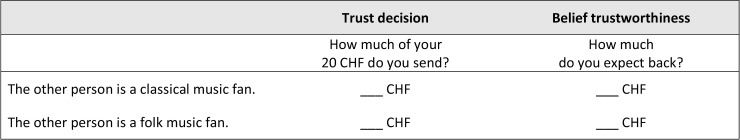
Trust decisions and beliefs of trustworthiness.The table shows how participants were asked for their investment decisions for the case that they were randomly allocated to the role of the sender (trustor). They are asked to make their decision in case they are matched with a classical music lover or a folk music lover. In addition, they are asked about their expected back transfers from each type of player they are matched with. The exact instructions are given in the text and the original screenshots from the online experiment are in the S1 File.